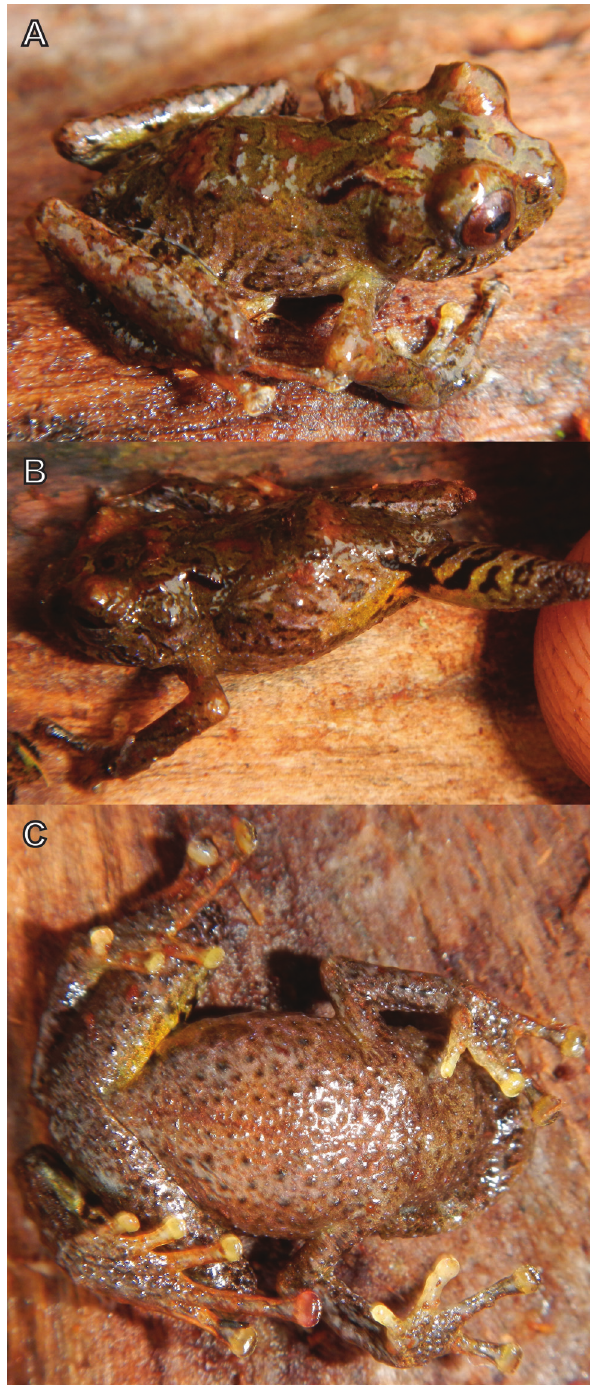
Fig. 3. Live holotype (MUSM 31102, SVL 14.1 mm) of Pristimantis boucephalus sp. nov. A . Dorsal view. B . Dorsolateral view. C . Ventral view. Photos by E.